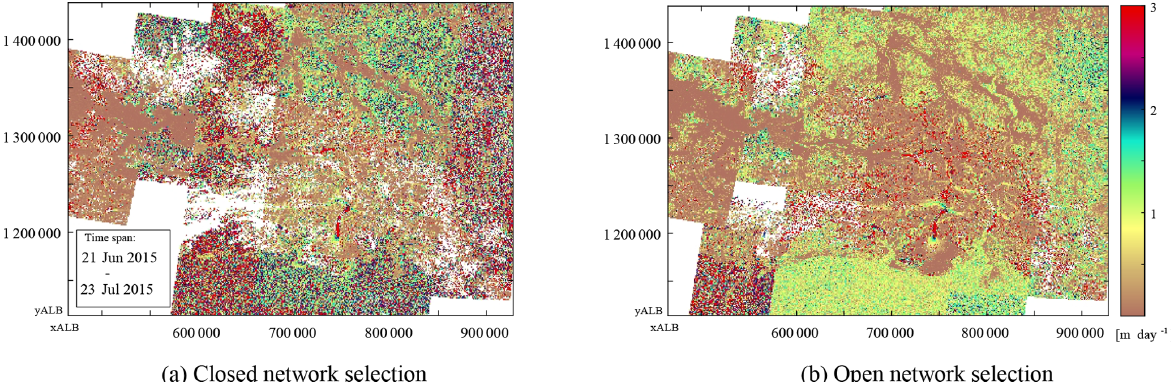
Figure 6. Least-squares estimates of velocities for the region shown in Fig. 1 with different network configurations. See Fig. 3 for a toy example of the terminology. The study region is spread over several UTM zones; hence the dataset is in Albers equal-area projection (ALB) with North American Datum 83. White regions correspond to data without an estimate.